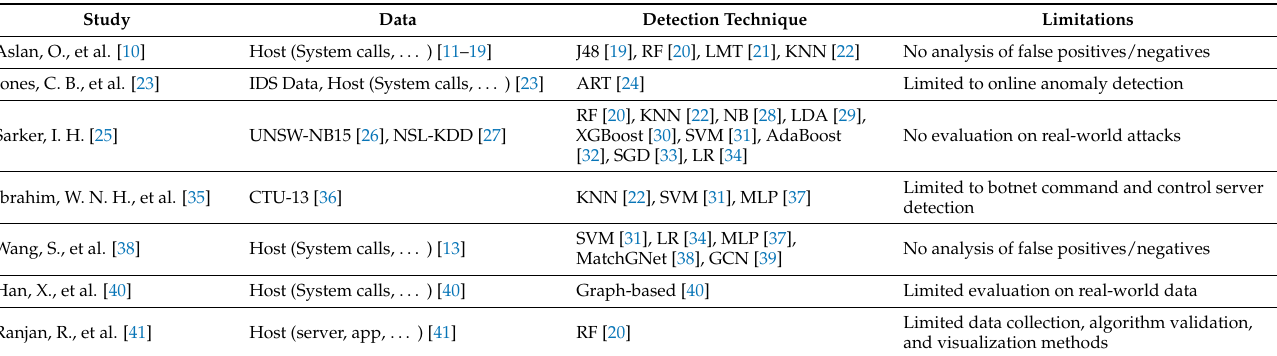
Table 1. Behavior-based data and detection methods in related